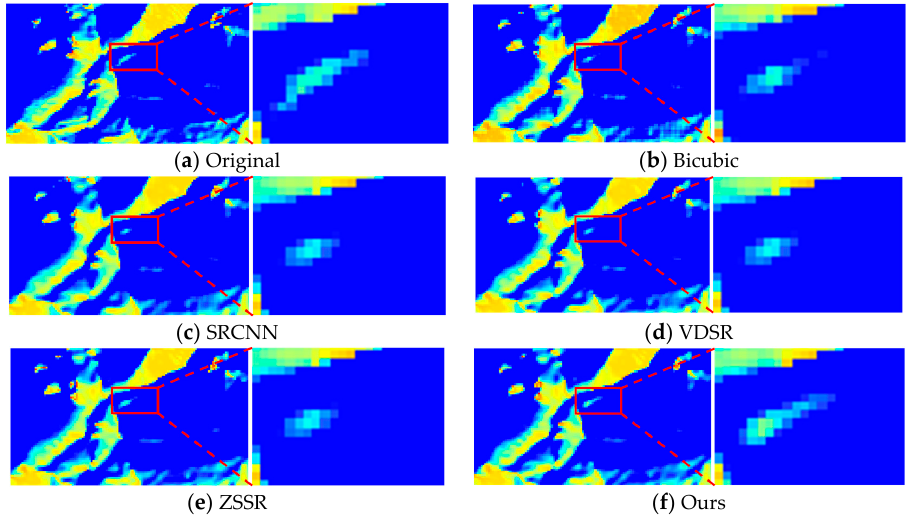
Figure 8. Detailed textures of the original DEM and the DEM after super ‐ resolution reconstruction of the DEM using different methods: ( a ) The texture details of the original DEM; ( b ) The texture details of DEM after DEM super ‐ resolution reconstruction using the bicubic method; ( c ) The texture details of DEM after DEM super ‐ resolution reconstruction using SRCNN with external learning in deep learning; ( d ) The texture details of DEM after DEM super ‐ resolution reconstruction using VDSR with external learning in deep learning; ( e ) The texture details of the DEM after DEM super ‐ resolution reconstruction using internal learning ‐ based ZSSR in deep learning; ( f ) The texture de ‐ tails of the DEM after DEM super ‐ resolution reconstruction using our proposed new method of combined internal and external learning. Quantitative analysis distribution, the super ‐ resolution reconstructed DEM can be measured by Root Mean Square Error ( RMSE ), Peak Signal ‐ to ‐ Noise Ratio ( PSNR ), Mean Absolute Error ( MAE ) and Median Absolute Deviation ( MAD ) [31]. The test dataset is selected from 24 DEM